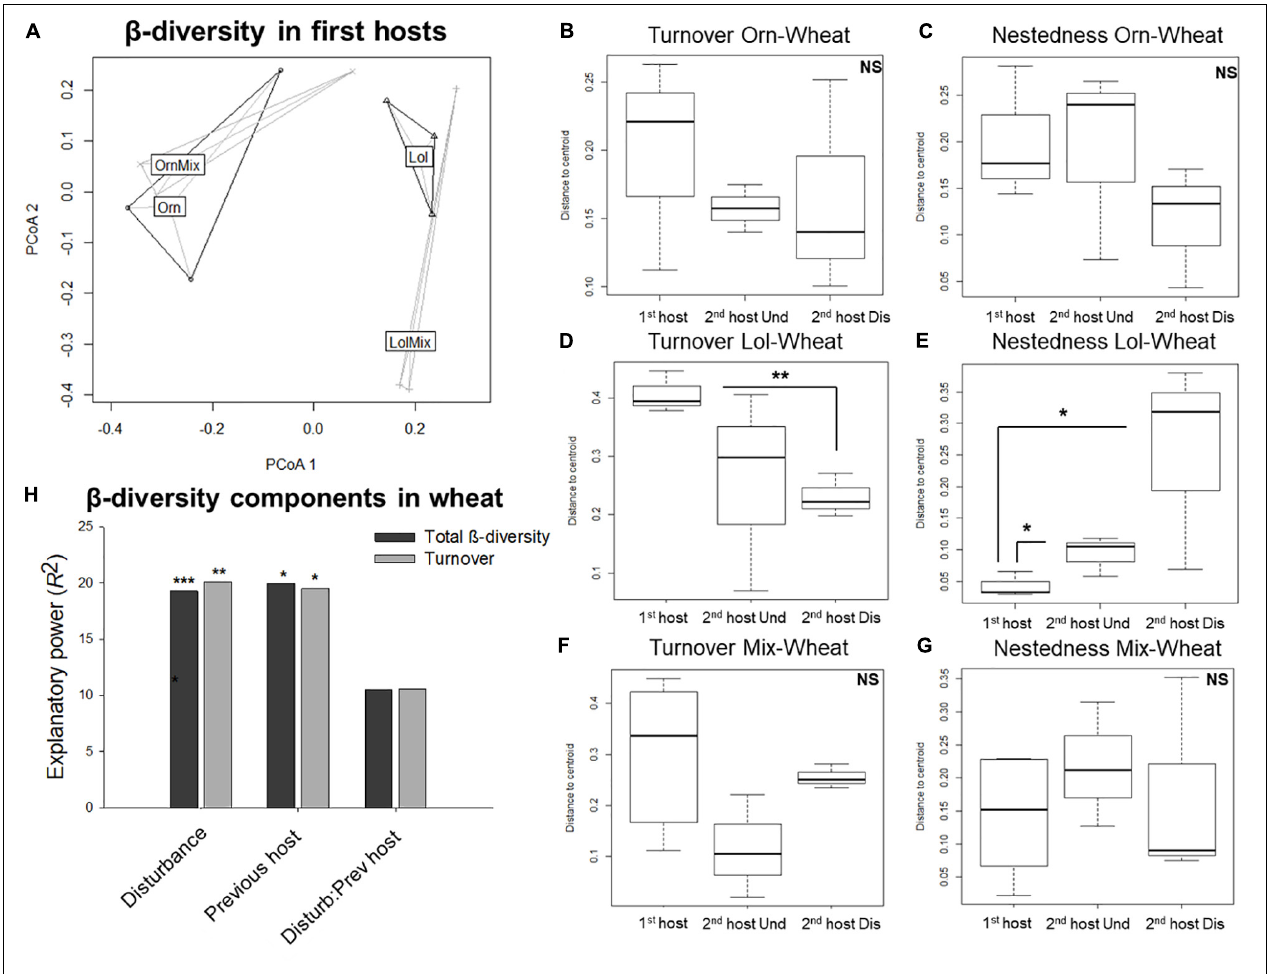
FIGURE 4 | Arbuscular mycorrhizal fungi β -diversity in the transition from Ornithopus compressus and/or Lolium rigidum to wheat ( Triticum aestivum ). (A) AMF total β -diversity in the roots of first hosts in a principal coordinates space. (B–G) Boxplots showing the turnover and nestedness components of β -diversity between O. compressus and wheat (B,C) , L. rigidum and wheat (D,E) , and O. compressus + L. rigidum and wheat (F,G) , being wheat planted in either undisturbed (Und) or disturbed soil (Dis). Bold line represents median and the bottom and top of the box represent lower and upper quartiles. (H) Total amount of explanatory power ( R 2 , scaled to 100) provided by disturbance, previous host species and their interaction on wheat global AMF β -diversity and components, as calculated based on PERMANOVA. Nestedness was null. ∗∗∗ P < 0.001; ∗∗ P < 0.01; ∗ P < 0.05. NS, non-significant. In all cases: Orn, O. compressus alone; OrnMix, O. compressus neighbored by L. rigidum ; Lol, L. rigidum alone; LolMix, L. rigidum neighbored by O. compressus